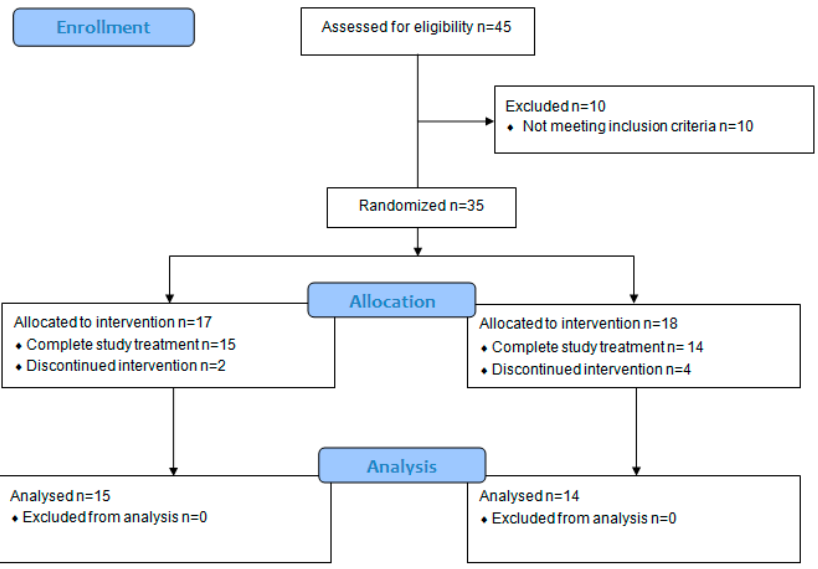
Figure 1. CONSORT flow diagram of the phases of the MiRACol randomized trial of the active and placebo group as well as the number of patients included in the analysis.